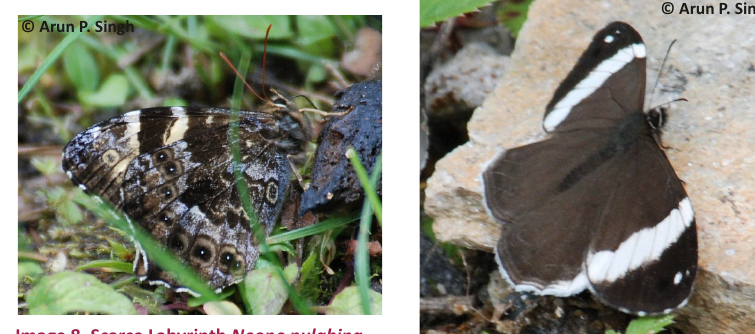
Image 8. Scarce Labyrinth Neope pulahina (Evans)